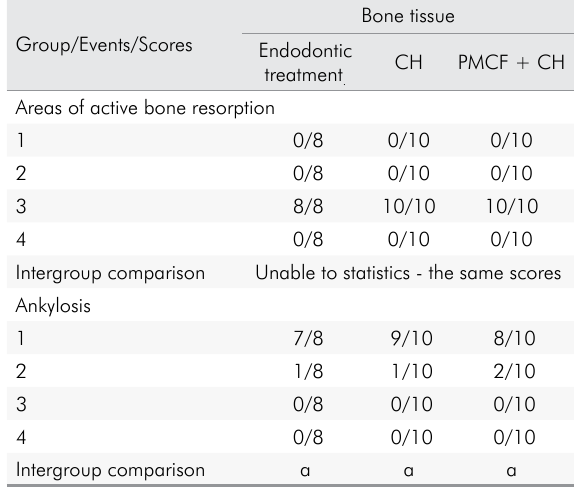
Table 4. Distribution of scores and statistical analysis of the histomorphometric events associated with periodontal ligament (Wilcoxon signed ranks test at 5% significance level).